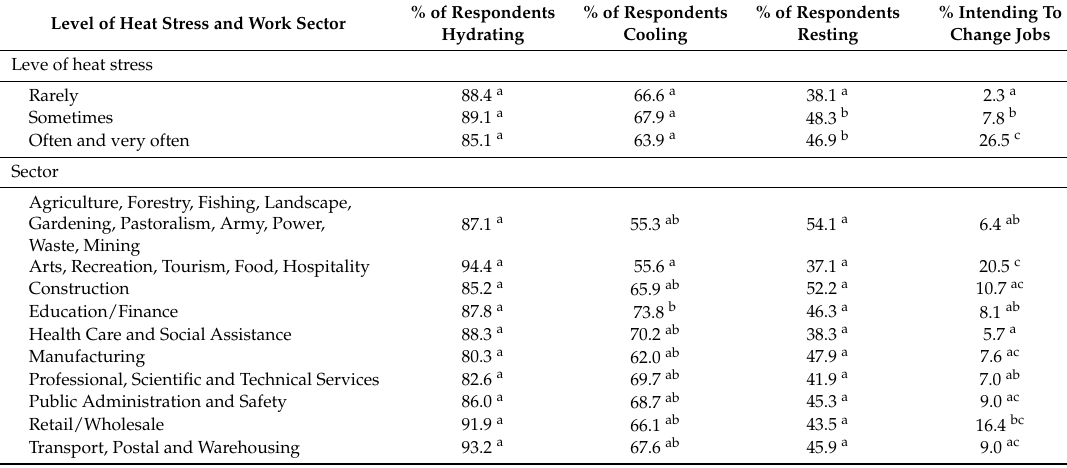
Table 4. Percentage of heat stressed respondents using different relief measures—by level of heat stress and work sector (N = 1285).